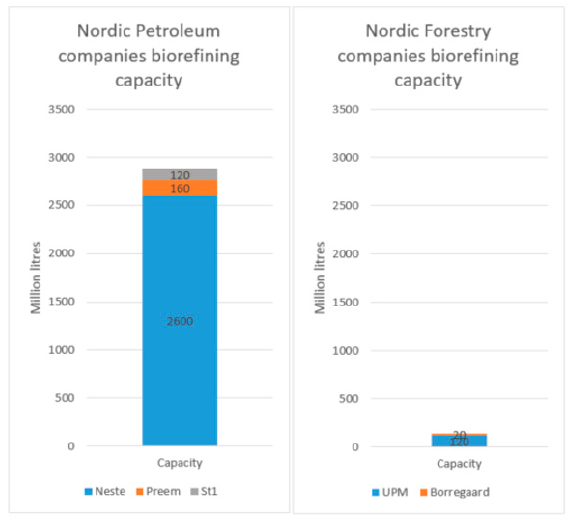
Figure 8. Biorefinery capacity 2018 [16–18,44].